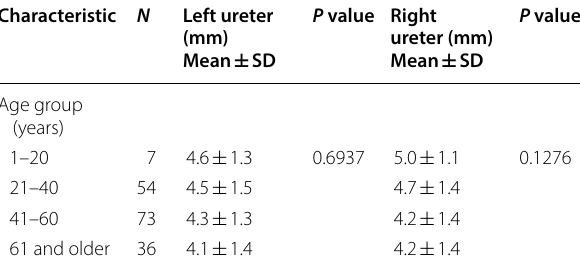
Table 3 Comparison of mean ureteric diameter by age group of